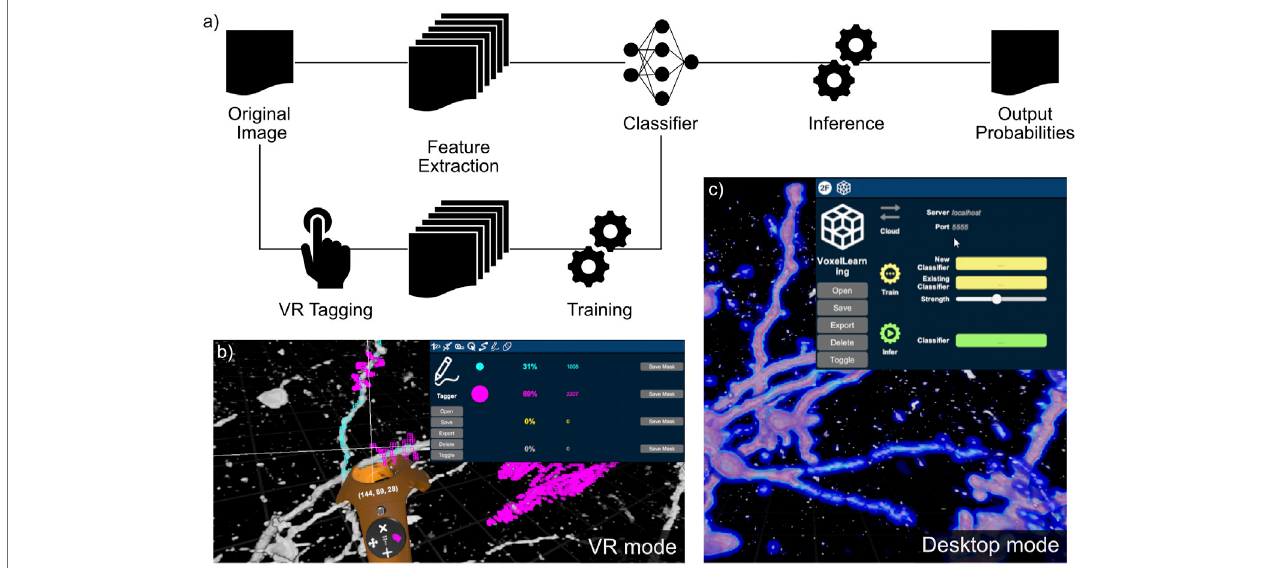
FIGURE 3 | Voxel Learning and its application on a confocal image stack of mouse olfactory bulb interneurons. (A) Schematic of the analysis pipeline. After having set visualization parameters, the user performs the VR tagging and selects the model to be used. Training and inference steps are performed on the cloud, as indicated bythepictogram. (B) DatataggingstepwiththeVRcontrollerinorange.Thepositiveandnegativetagsarecoloredincyanandmagenta,respectively. (C) VoxelLearning interface in DIVA with the output probabilities overlaid on the original image (0 corresponds to blue; 1 to